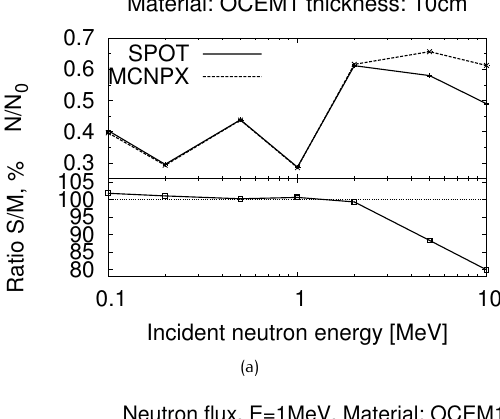
Figure 1. SPOT and MCNPX comparison: a) neutron transmittance vs. incident neutron energy for 10 cm concrete thickness, b) neutron flux for 1.0 MeV incident neutron energy transmittance vs. concrete thickness